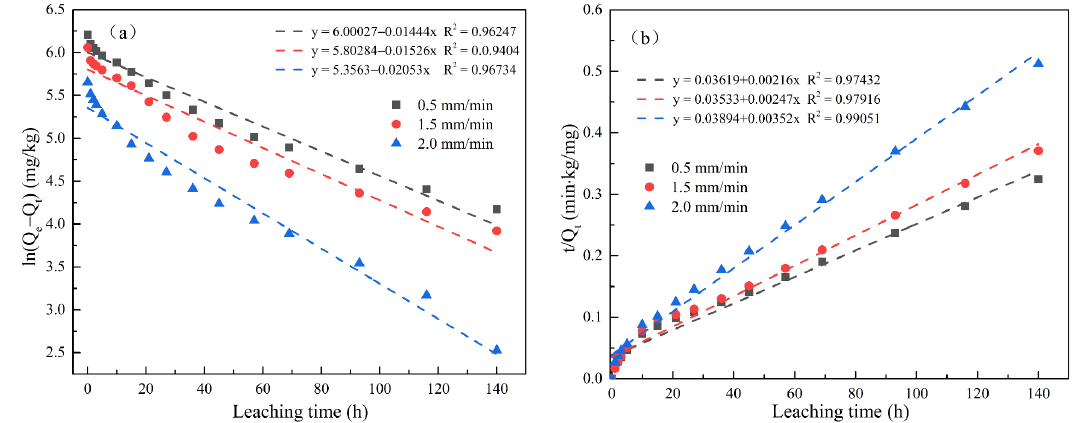
Figure 5. Linear regressions between ( a ) ln(Qe − Qt) and ( b ) t/Qt of the accumulation release amount for total cyanide.